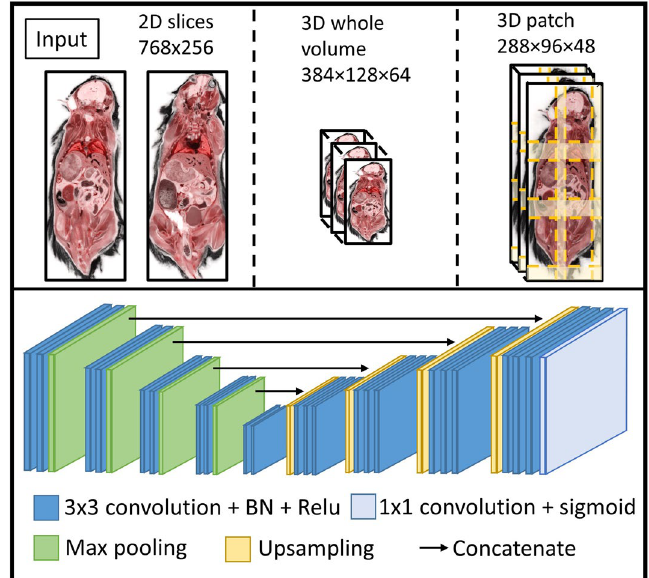
Figure 1. Overall workflow of organ segmentation. (Top) The input configurations for the three proposed methods. (Bottom) The network architecture for 2D U-Net. 3D U-Net has same architecture, except for the kernels being three